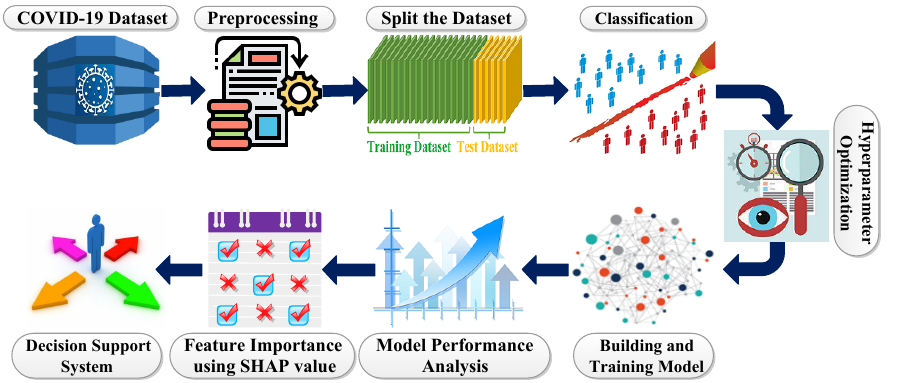
Figure 1. Proposed system architecture. Table 1. Description of the dataset used for COVID-19